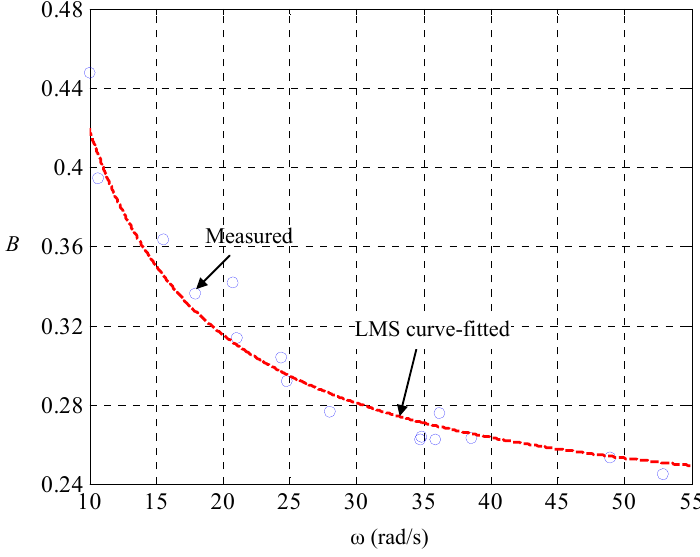
Figure 4. Identification of dependence of mechanical damping on tire